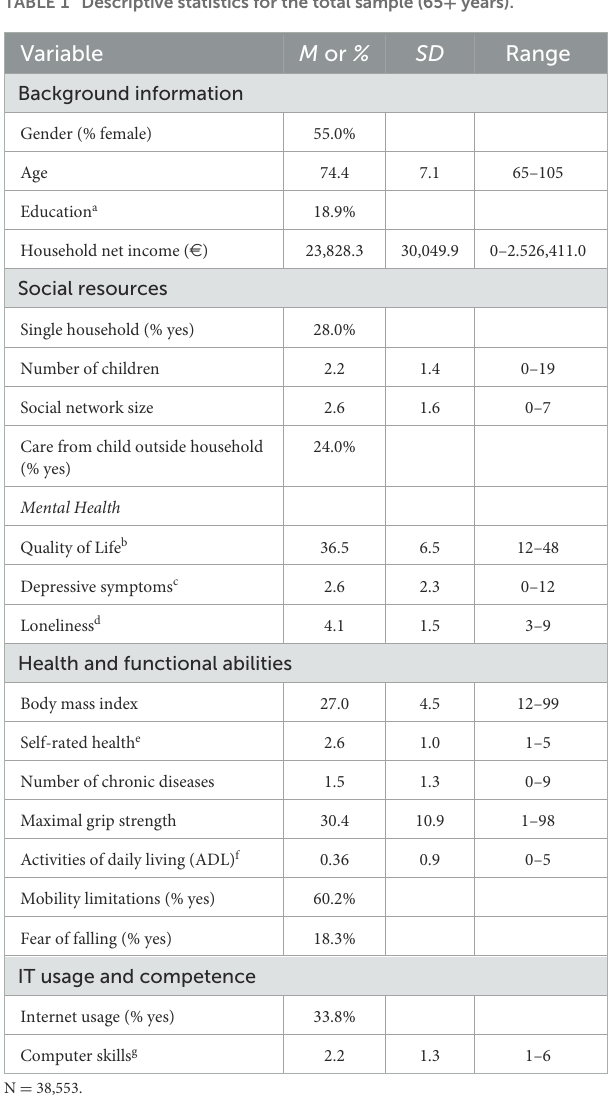
TABLE 1 Descriptive statistics for the total sample (65 +